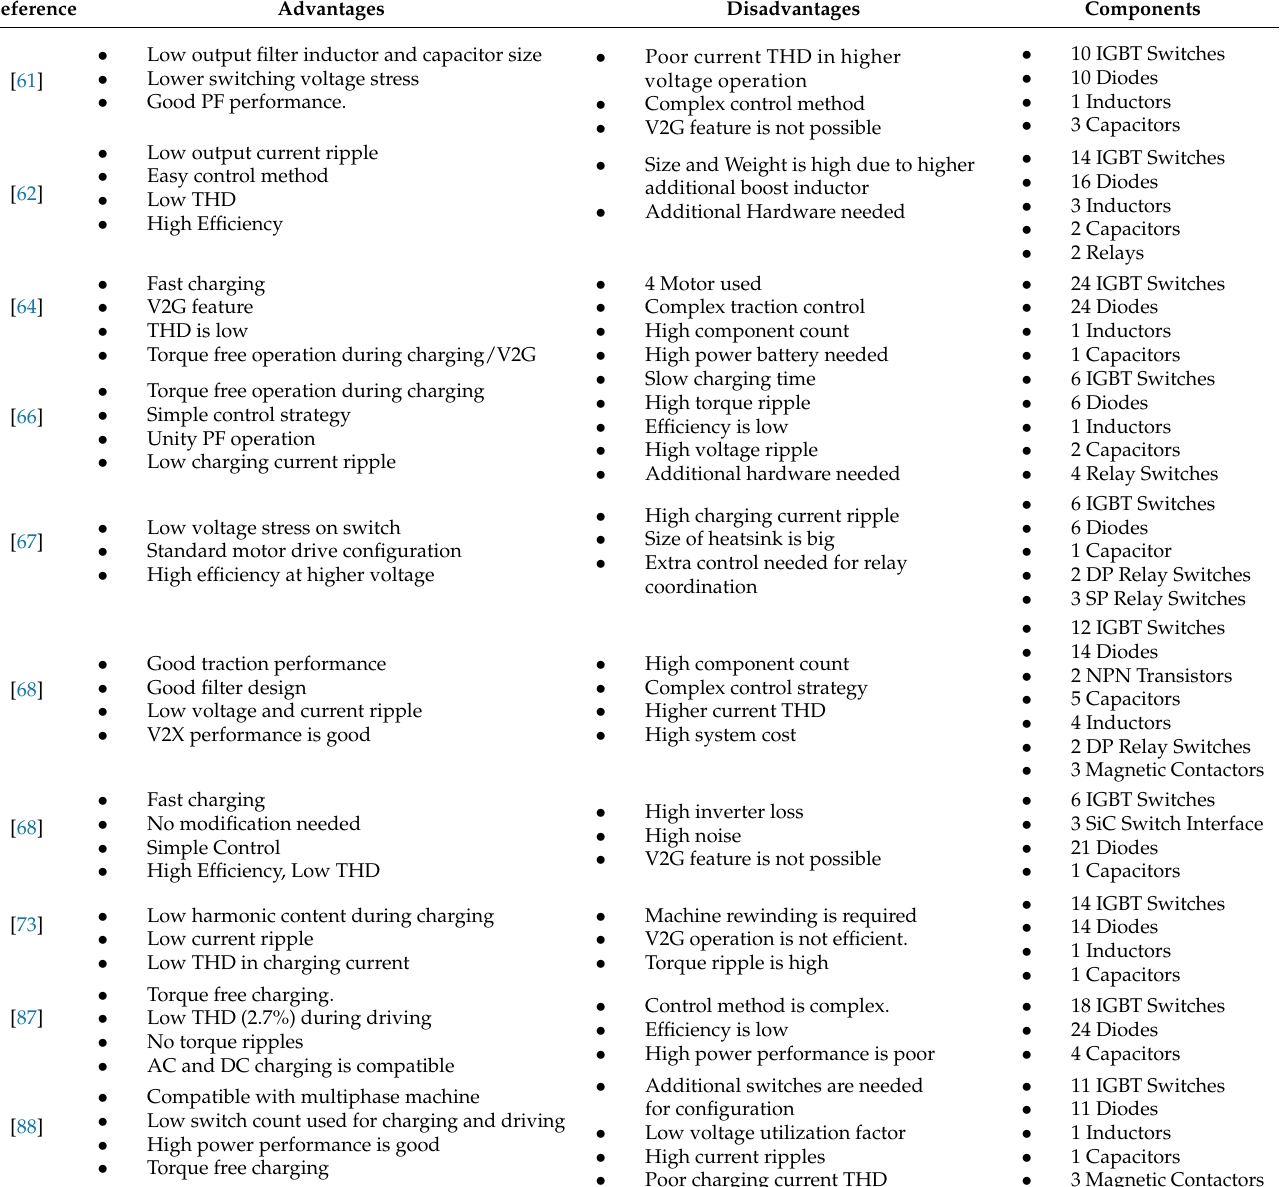
Table 6. Advantages and disadvantages of integrated on-board charger